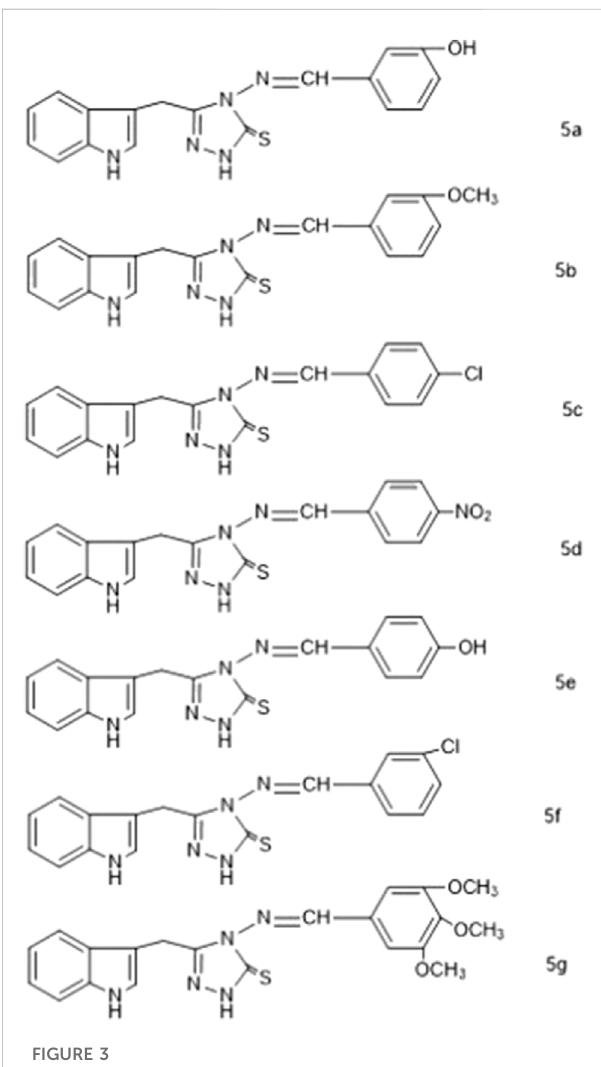
FIGURE 3 Proposed structures of synthesized compounds (5a-5g).